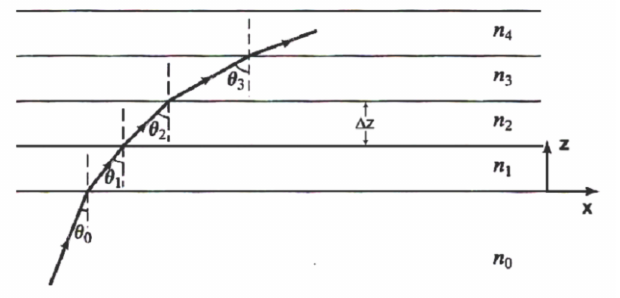
Figure 8. Ray trajectory in a planar stratified